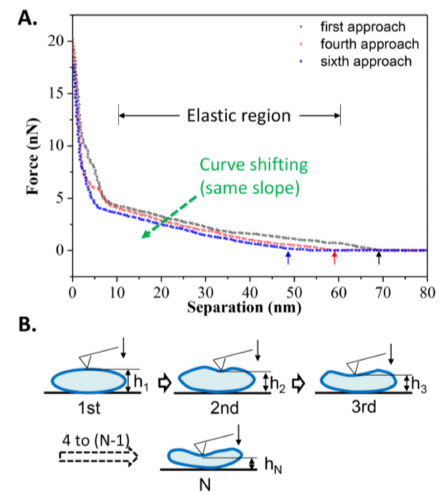
Figure 7. ( A ) Curve shifting of the repeated approach curves on an elastic DPPC vesicle obtained at T 2 = 25 ◦ C; ( B ) Schematic procedures simulating the repeated approach process. The arrows refer to the critical separation when repulsion force first